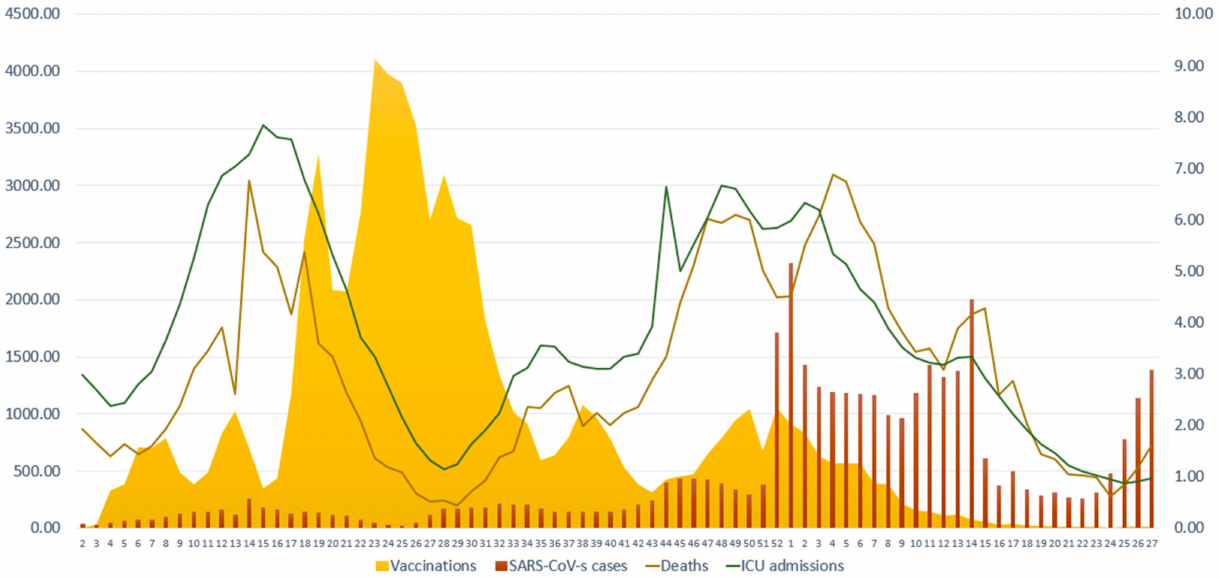
Figure 1. Number of new weekly SARS-CoV-2 cases, COVID-19-related ICU admissions, COVID-19- related deaths and vaccinations against SARS-CoV-2 during the study period. The scale for SARS-CoV-2 cases and vaccinations is on the left y axis (0–4500) and the scale for COVID-19-related ICU admissions and COVID-19-related deaths is on the right y axis (0–9). Data are expressed per 100,000 population. X axis corresponds to the number of